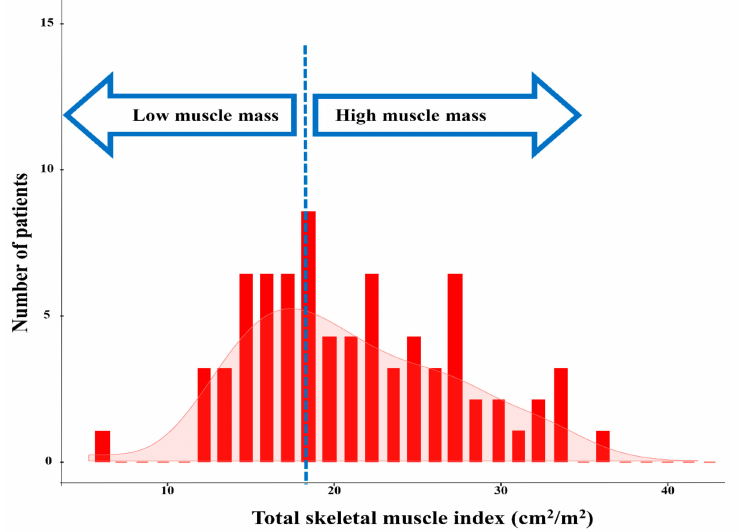
Figure 3. Distribution of the total skeletal muscle index in the pediatric patients undergoing the Fontan operation (red